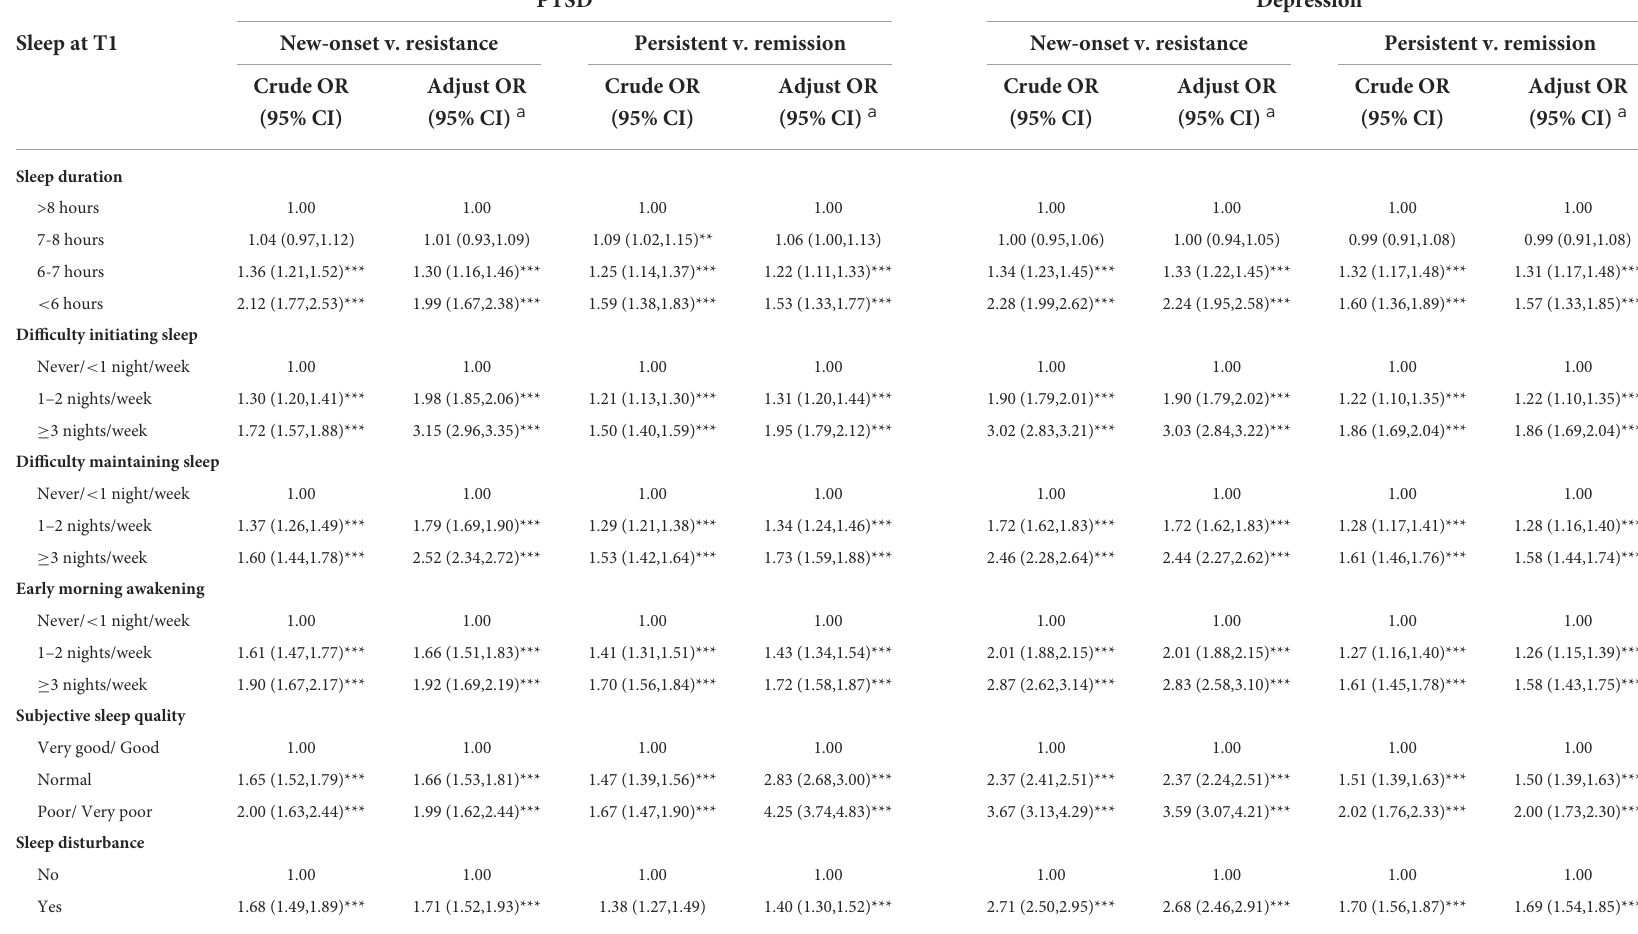
TABLE 4 Sleep disturbance predicting change of PTSD or depression during